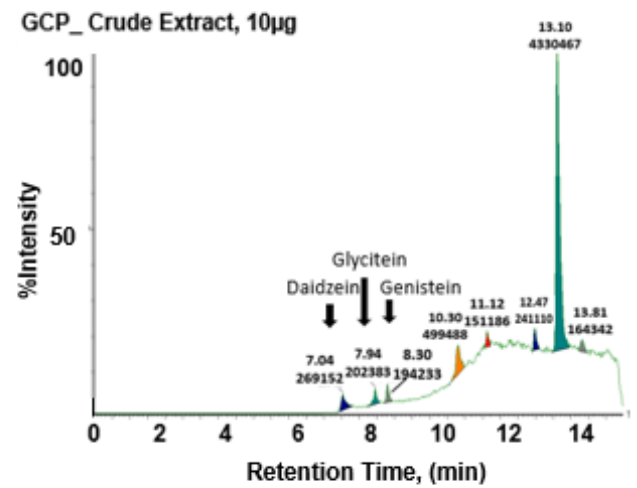
Figure 1. UPLC-MS demonstrate s genistein combined polysaccharide (GCP) comprises of high levels of genistein, daidzein, and glycitein as well as other unknown compounds. Our analysis comparing GCP to genistein, daidzein, and glycitein standards revealed that GCP comprises 9% genistein, 6% daidzein, and 2% glycitein. Multiple other peaks of unknown identity were also observed, demonstrating GCP is a complex mix of